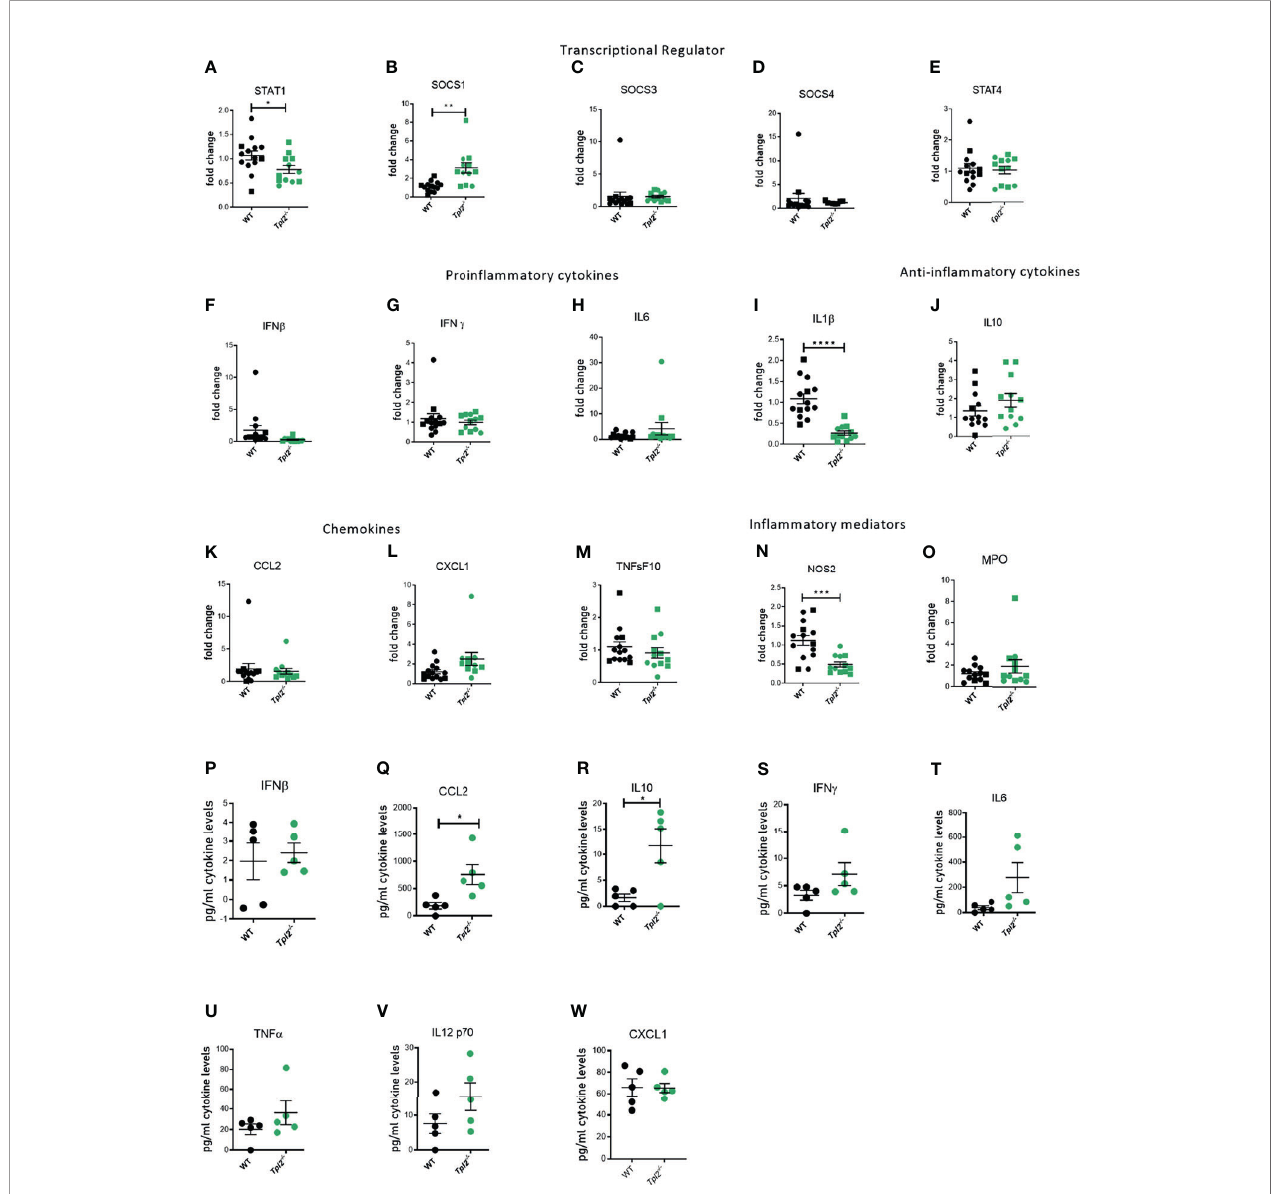
FIGURE 5 | Ineffective suppression of CCL2 protein levels despite transcriptional repression in in fl uenza-infected Tpl2 -/- mice at 9 dpi. WT (n = 5) and Tpl2 -/- (n = 5) mice were infected intranasally with 10 4 pfu of in fl uenza x31 and euthanized at 9 dpi. (A – O) WT (14) & Tpl2 -/- (11) lungs were homogenized and analyzed for gene expression for transcriptional regulators (A – E) , pro-in fl ammatory cytokines (F – I) , anti-in fl ammatory cytokines (J) , chemokines (K, L) and in fl ammatory mediators (M – O) . (P – W) The lungs were homogenized and assessed for cytokine protein levels. Squares represent male mice, and circles represent female mice. Data are representative of 2 experiments. Unpaired student ’ s t -test *p<0.05, **p<0.01, ***p<0.001,